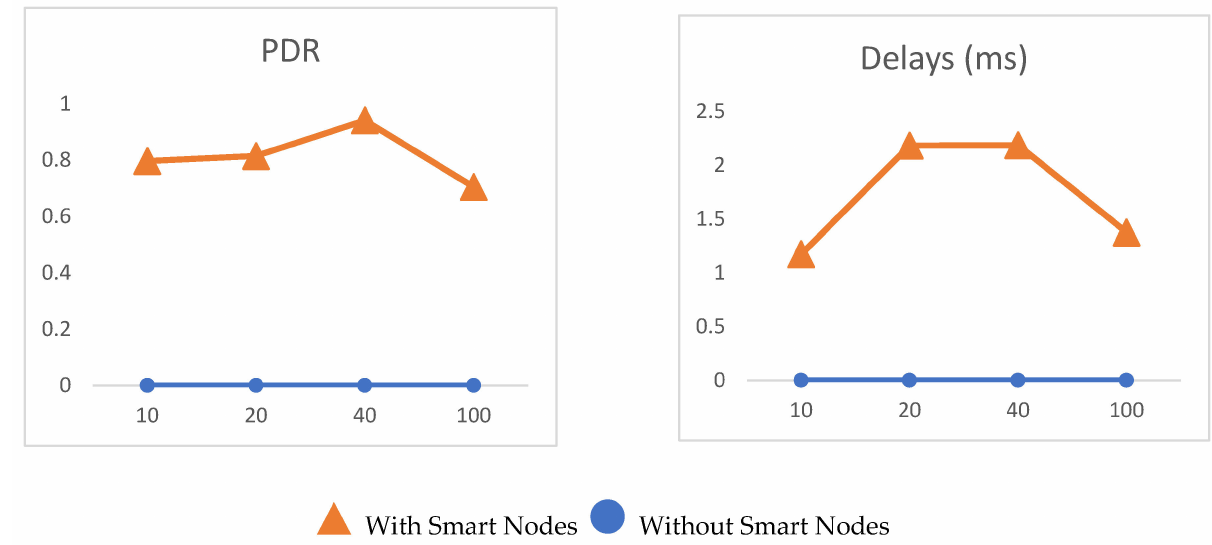
Figure 10. Case 1: Uncommon communication type.